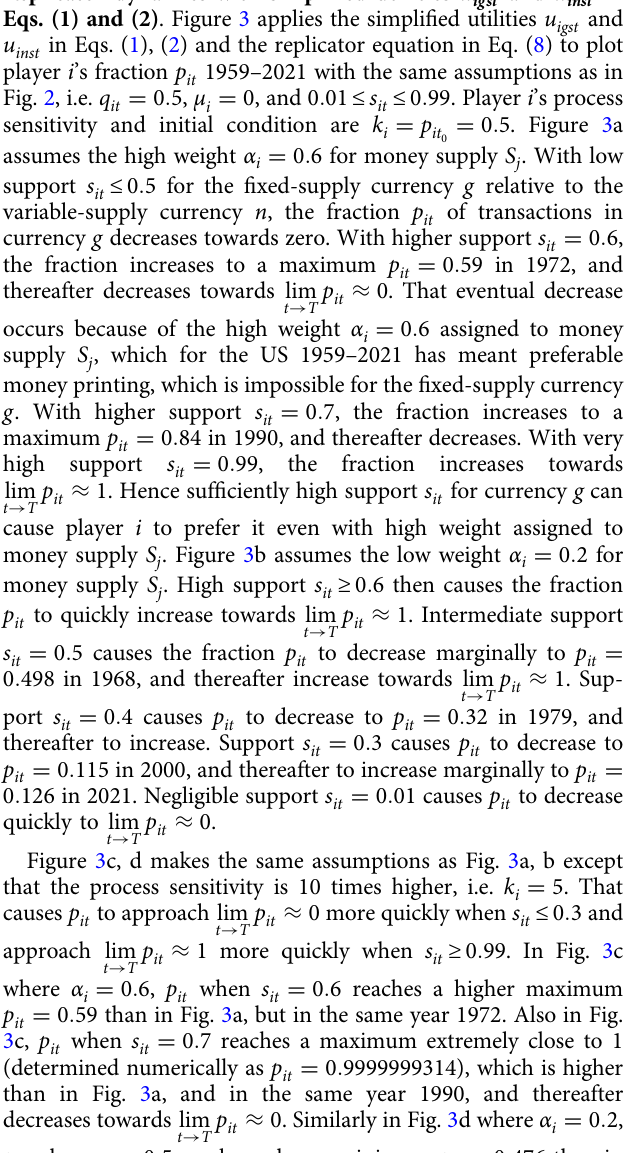
¼ 0 : 5, μ ¼ 0, and 0 : 01 ≤ s it i